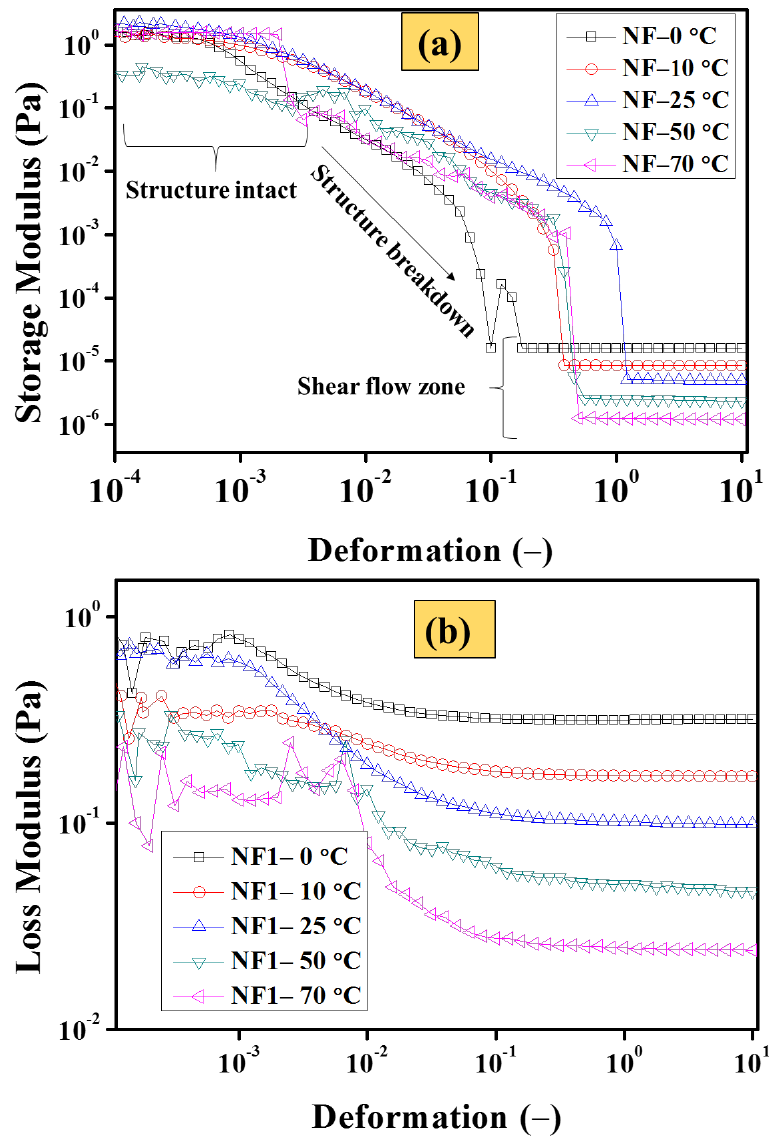
Figure 12. Oscillatory strain sweep analysis at a constant frequency of 1 Hz for NF1 ( a ) storage (G ′ ) and ( b ) loss (G ″ ) modulus.